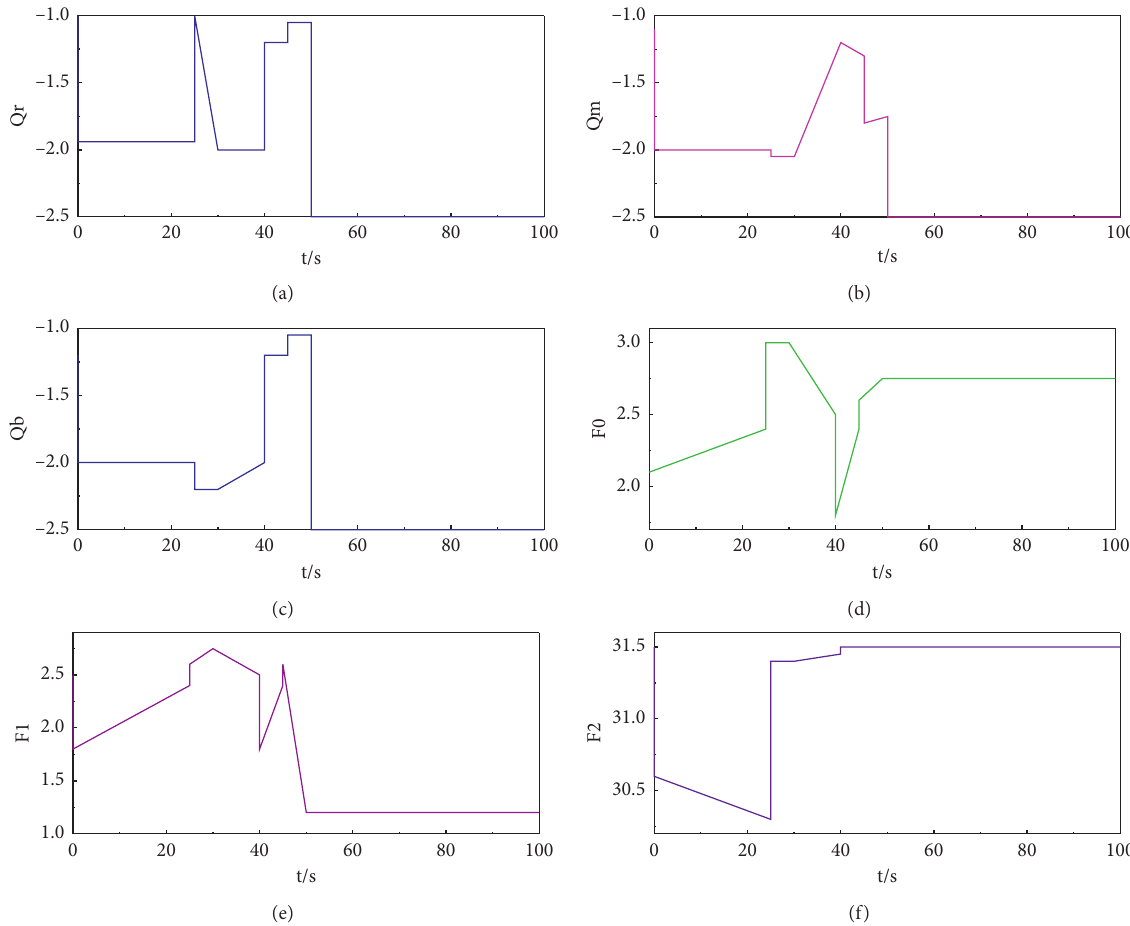
Figure 11: Sequence diagram of each control variable of the system under the RCO